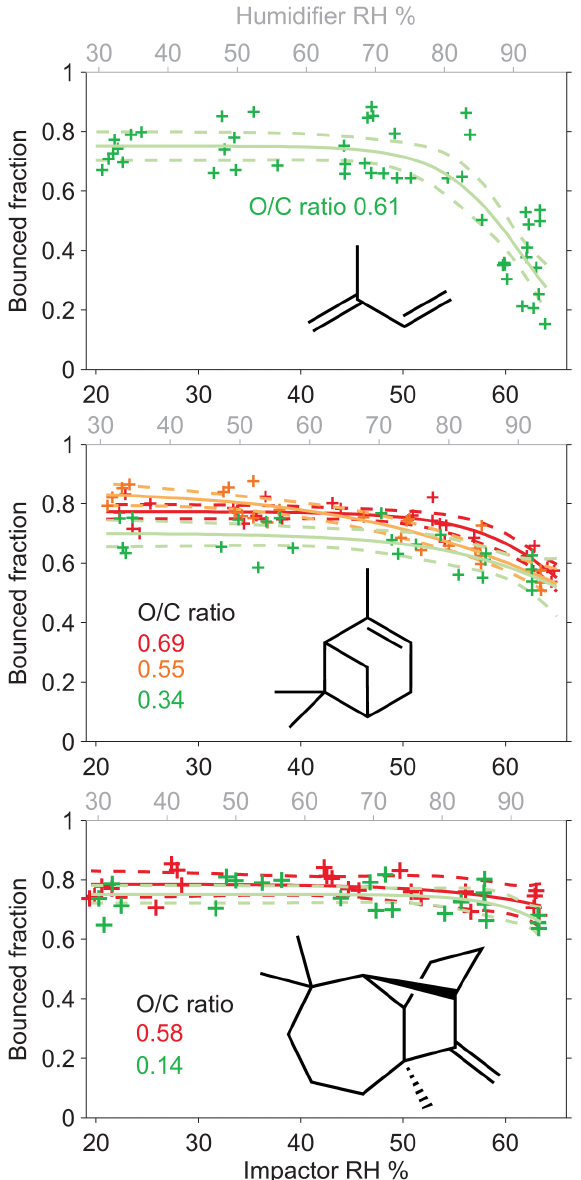
Fig. 4. Bounce behavior of SOA from photo-oxidation experiments of biogenic precursors, solid lines are sigmoid fits to guide the eye, dashed lines give the 95% confidence bounds for the fits. Upper panel: isoprene SOA, middle panel: α -pinene SOA, lower panel: longifolene